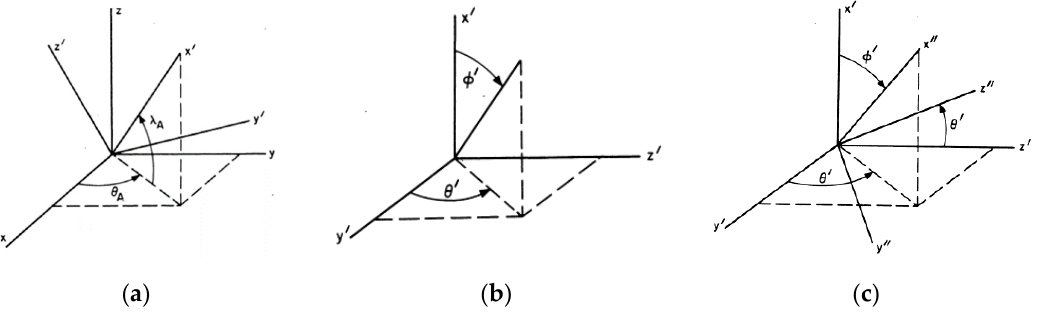
Figure 4. ( a ) Relationship of x, y, z and x', y', z' coordinate axes; ( b ) the direction of incident beam after reflection; and ( c ) the relationship of x', y', z' and x", y", z" axes.